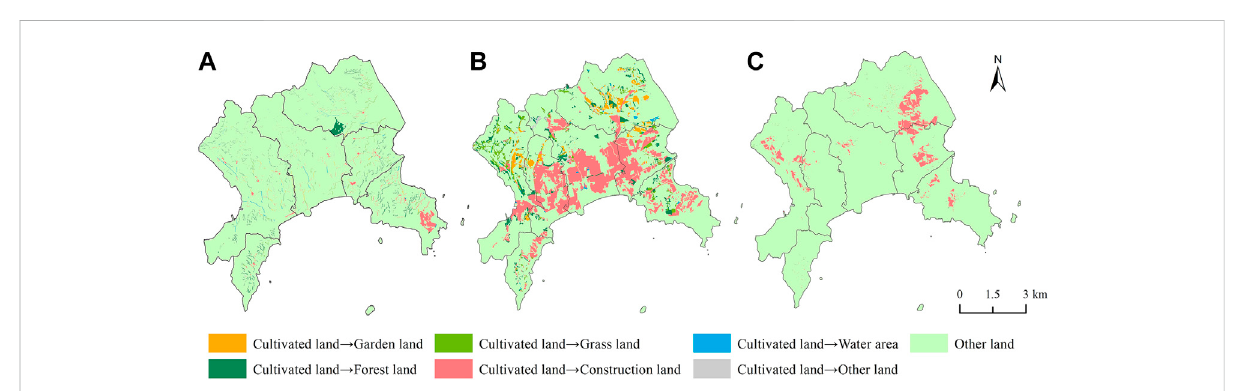
Flow chart of cultivated land in Jinshitan from (A) 1988 – 1998, (B) 1998 – 2009, and (C) 2009